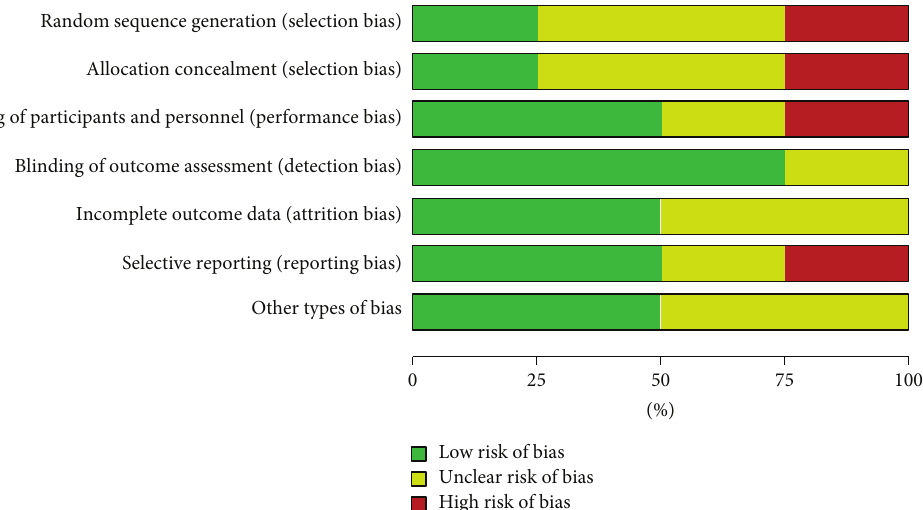
Figure 2: Risk of bias graph: review authors’ judgments about each risk of bias item presented as percentages across all included studies.